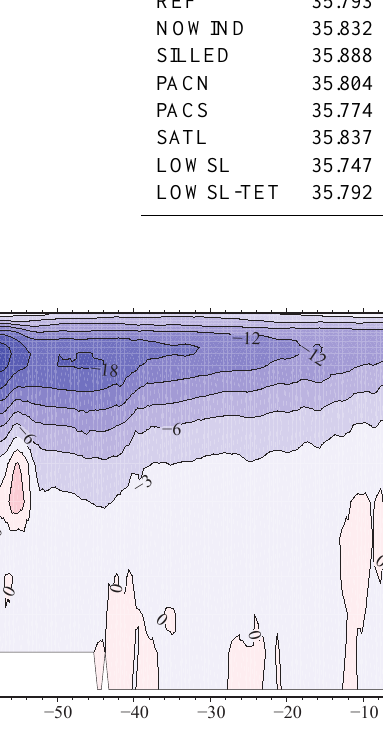
Fig. 6. REF zonal overturning. Zonal overturning in the North Atlantic Basin. Contour lines are drawn every 3Sv, blue colours indicate negative (counterclockwise in this view) overturning and red colours positive (clockwise). In the East, this graph stops at the Tethys sponge while the boundary with the Pacific sponge does not run N–S. Consequently, west of 52 ◦ W the overturning streamfunc- tion shown is affected by overturning in the sponge. The positive cells between 2000 and 4000m are an artifact